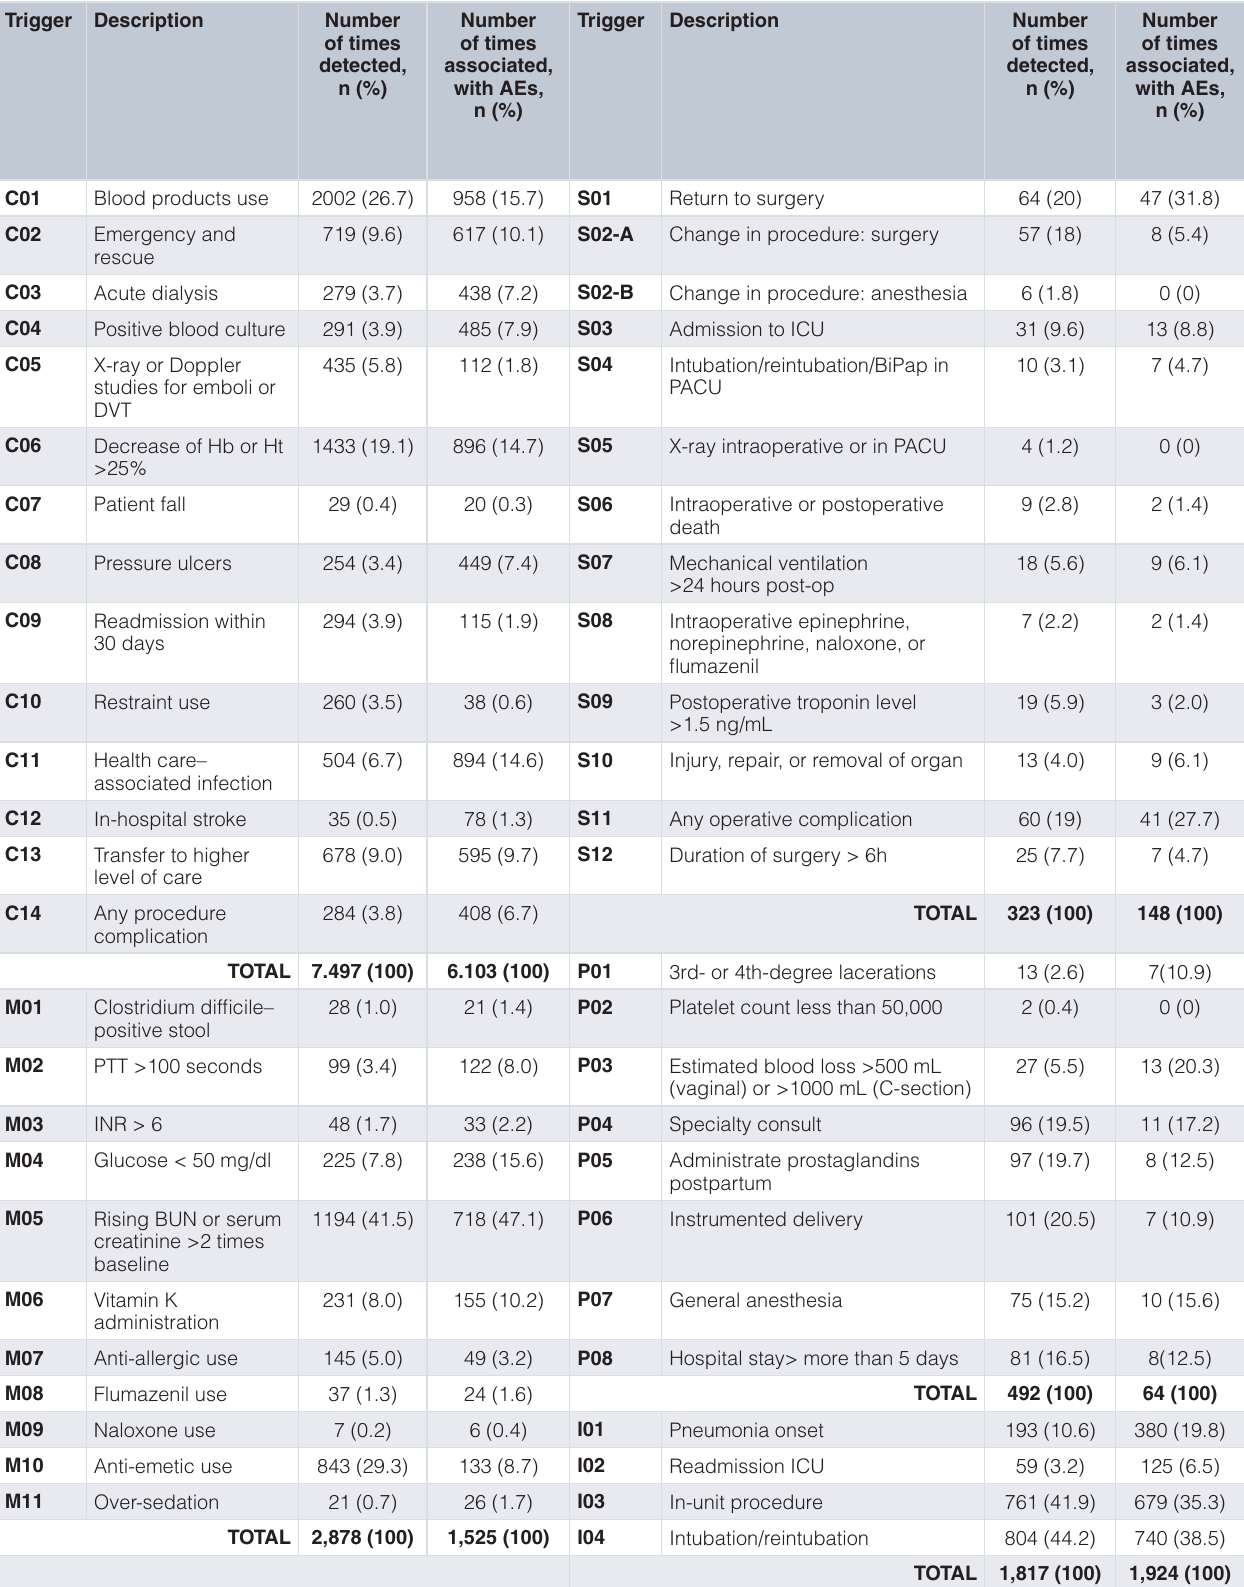
Table 2. Distribution of general care triggers and AEs. Trigger